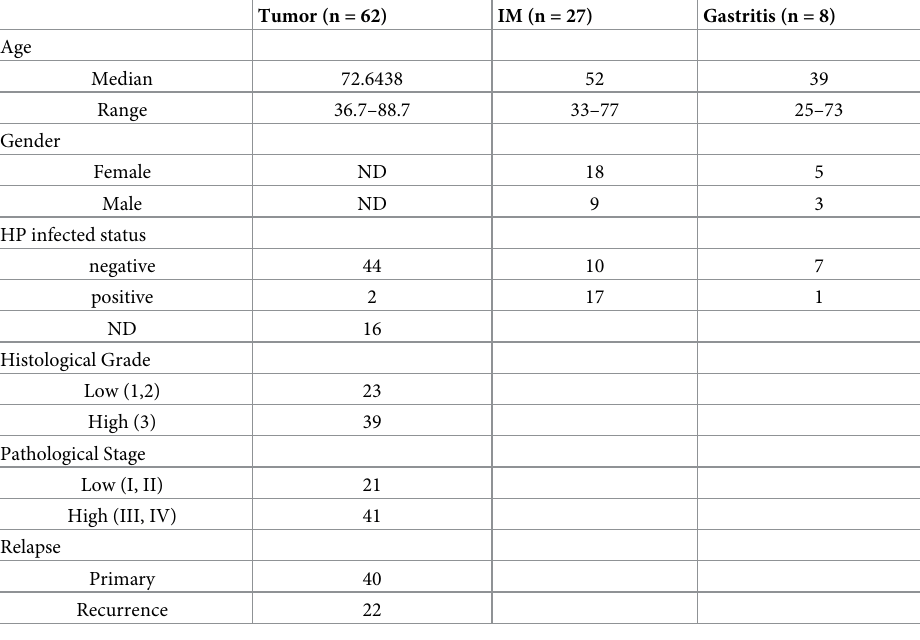
Table 1. Summary of clinic-pathological data of patient